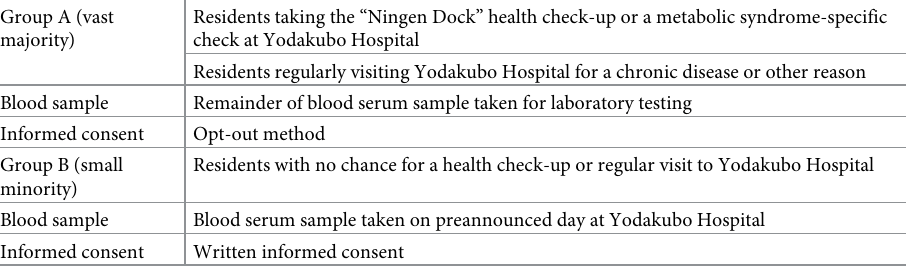
Table 1. Method for obtaining blood samples and informed consent in the Nagawa